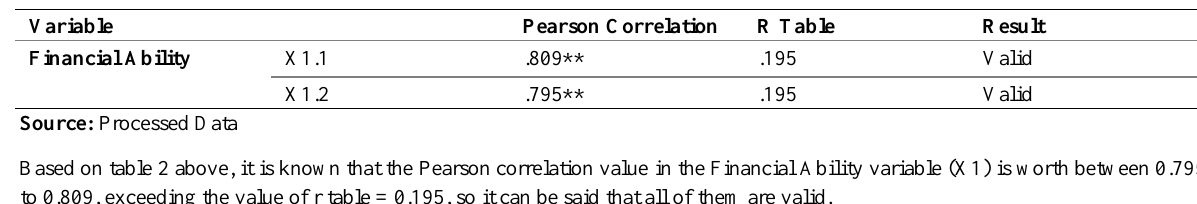
Table 2: Financial Ability Validity Test Results